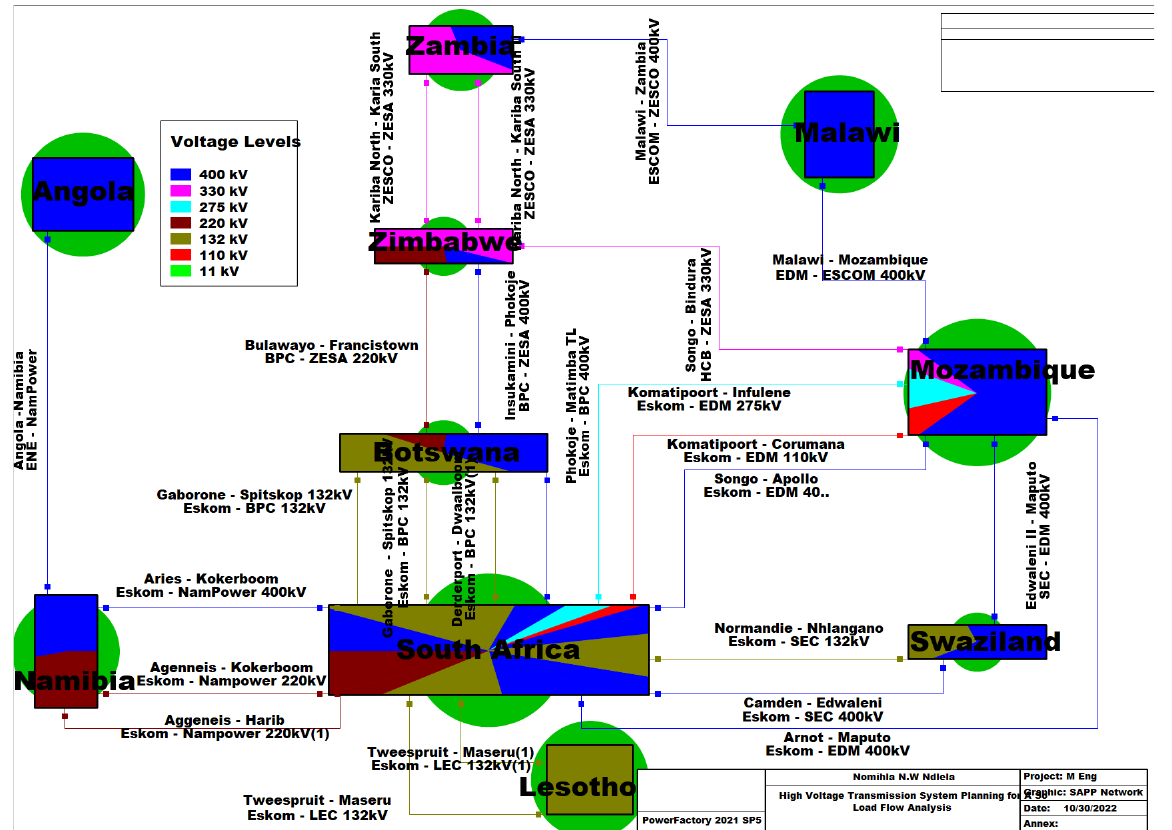
Figure 4. South Africa proposed a network model.